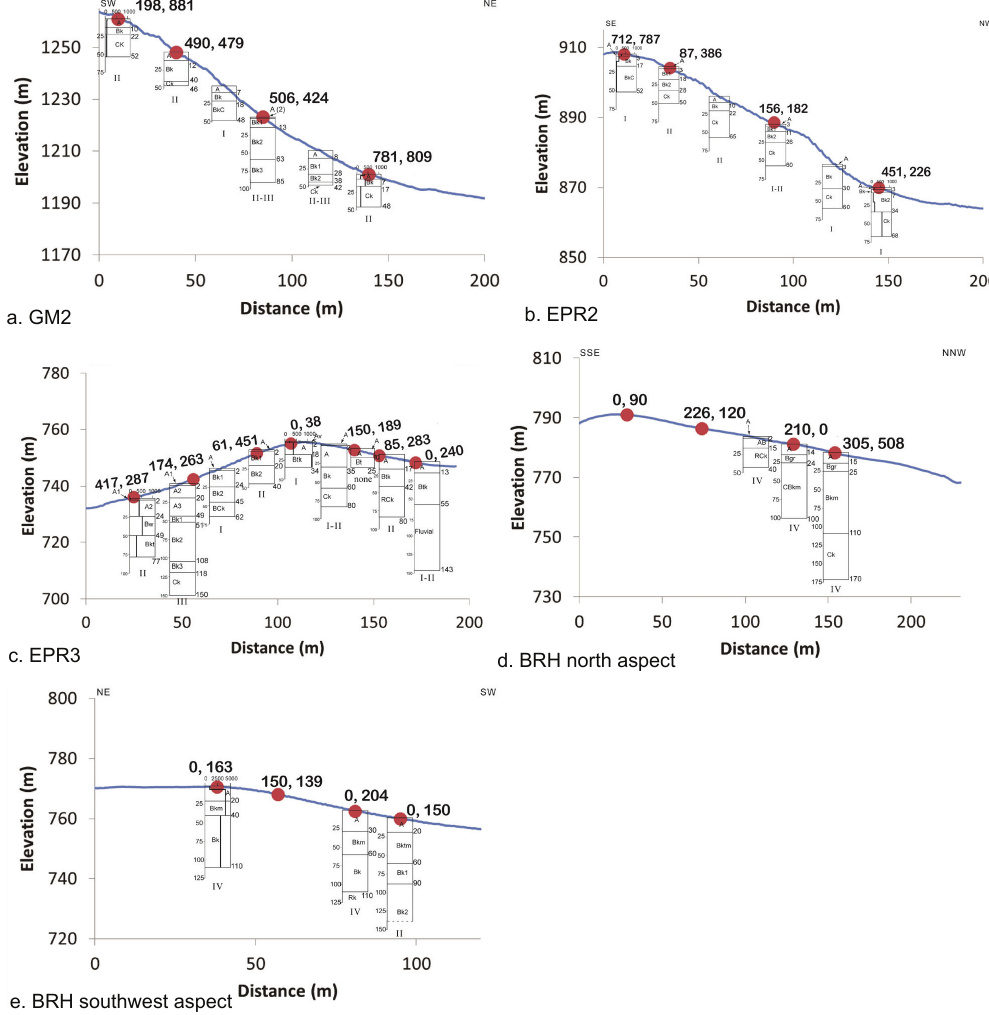
Figure 6. The distribution of total 137 Cs inventories (Bqm − 2 ) per soil pit along the hillslope for each study site: (a) GM2, (b) EPR2, (c) EPR3, (d) BRH north aspect, (e) BRH southwest aspect. The distribution of electrical conductivity values (EC) (µScm − 1 ) with depth is presented for most of the summit and footslope profiles. Note scale difference for EC values at site